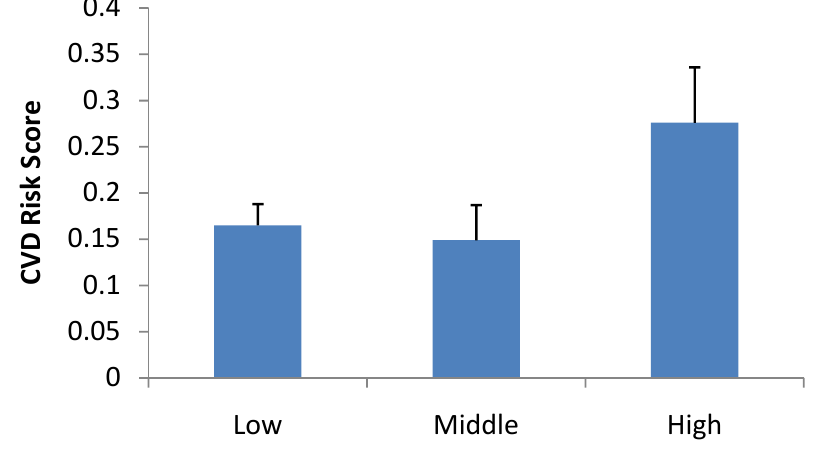
Figure 2. The association between BMI and CVD risk in Portuguese children.